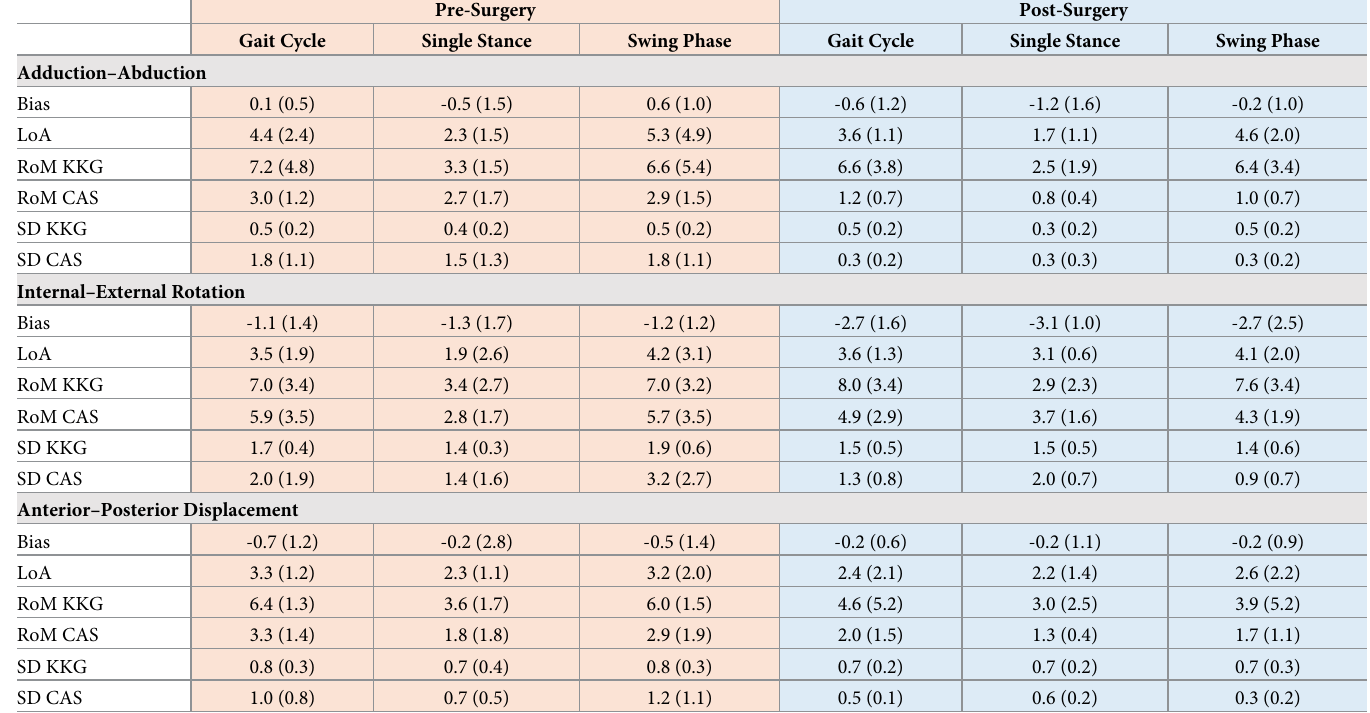
Table 2. Bias (b), limits of agreement (LoA), ranges of motion (RoM) and square root of the variance averaged over the gait cycle (SD) with KneeKG (KKG) and Computer-Assisted Surgery (CAS) for each degree of freedom and for the whole gait cycle, the single stance phase and the swing phase, both before and after TKA. Results are reported in degrees as: Median (Inter-Quartile Range).